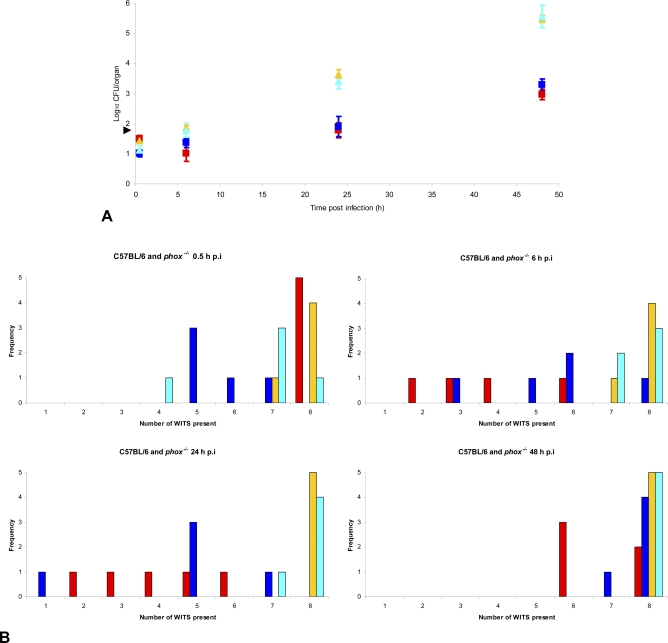
CFU and WITS Frequency in Infected C57BL/6 and phox−/− Mice
phox−/− mice and congenic wild-type control mice on a C57BL/6 background were infected i.v. with approximately 80 to 100 CFU of S. Typhimurium WITS. (A) shows bacterial numbers and (B) the frequency of WITS recovered, from the C57BL/6 liver (red square), C57BL/6 spleen (blue square), phox−/− liver (golden triangle), and phox−/− spleen (cyan triangle) at 0.5, 6, 24, and 48 h p.i. Results are expressed as log10 viable count ± standard deviation; arrow indicates inoculum.